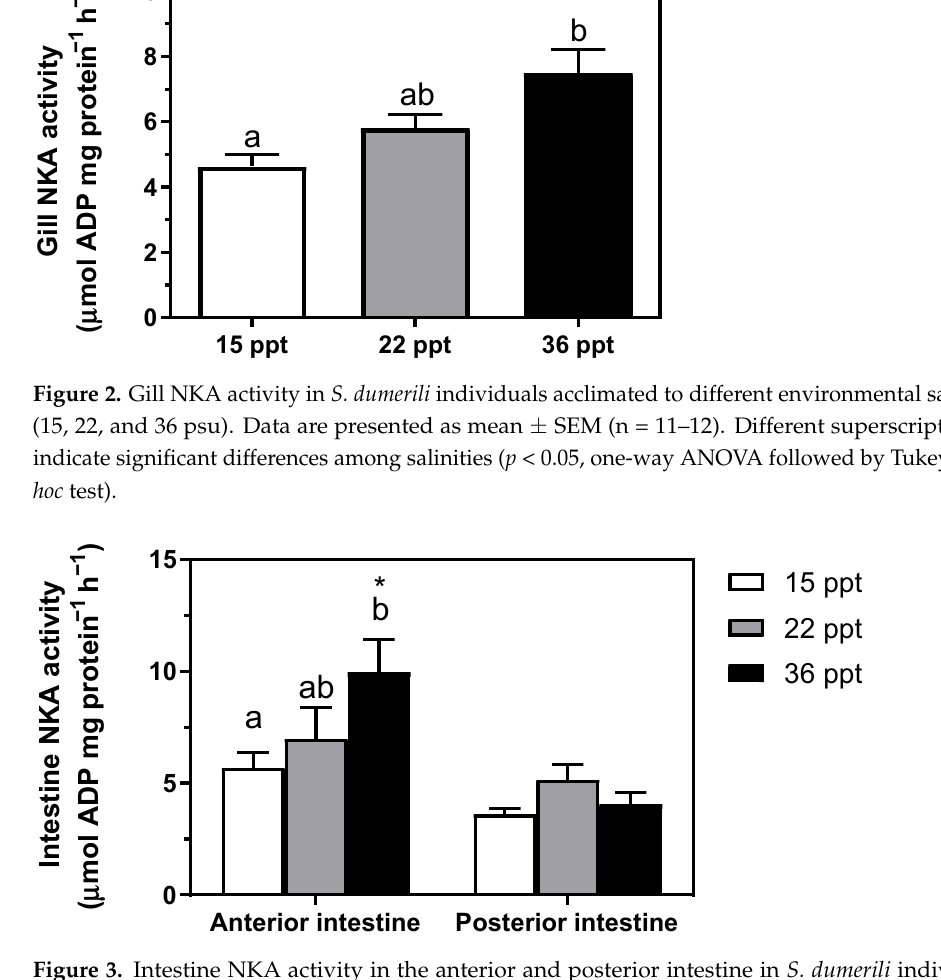
Figure 3. Intestine NKA activity in the anterior and posterior intestine in S. dumerili individuals acclimated to different environmental salinities (15, 22, and 36 psu). Data are presented as mean ± SEM (n = 7–12). Different superscript letters indicate significant differences among salinities in a given intestinal region. Asterisks (*) indicate significant differences between intestinal regions within a given salinity ( p < 0.05, two-way ANOVA followed by Tukey´s post hoc test).